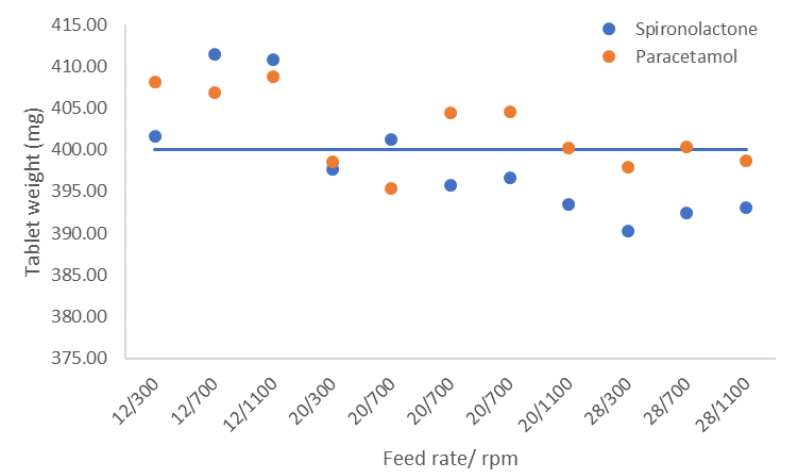
Figure 6. The e ff ect of total feed rate (i.e., turret speed in tablet press) and mixer speed on tablet weight.